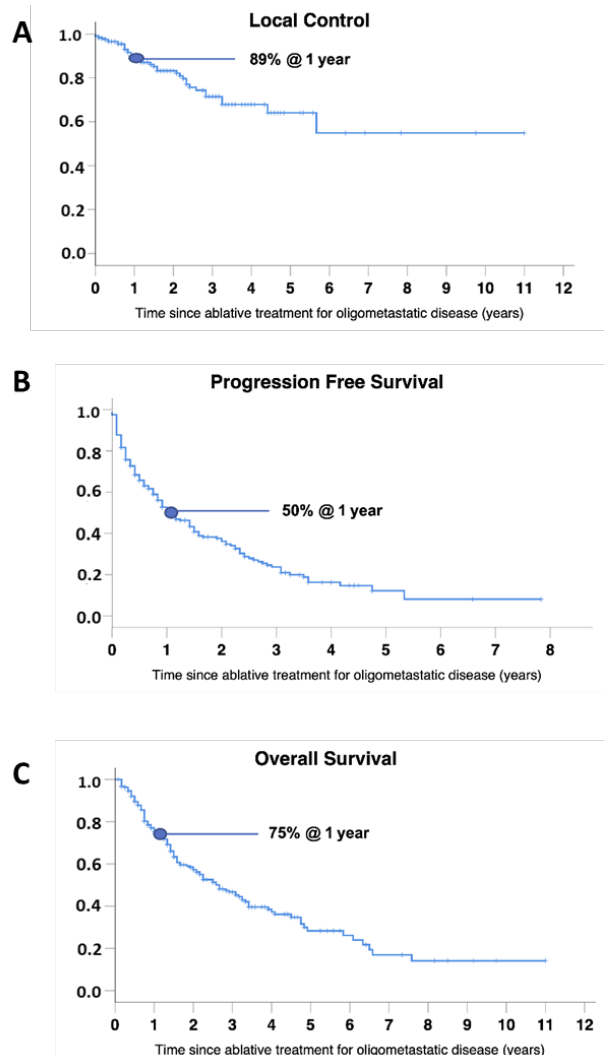
Figure 1. LC ( A ), PFS ( B ) and OS ( C ) in the overall population. Table 3. Univariate and Multivariate Cox Regression of Factors Predicting Progression-Free Sur- vival and Overall Survival. Variable Progression-Free Survival Overall Survival Univariate Multivariate Univariate Multivariate